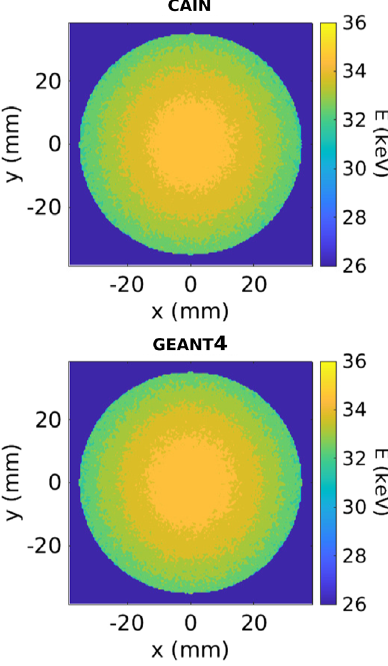
FIG. 6. Spatial distribution of energy at a distance from the IP of 10 m for the BriXS photon beam simulated with CAIN and GEANT 4 within a collimation angle of 3.5 mrad.